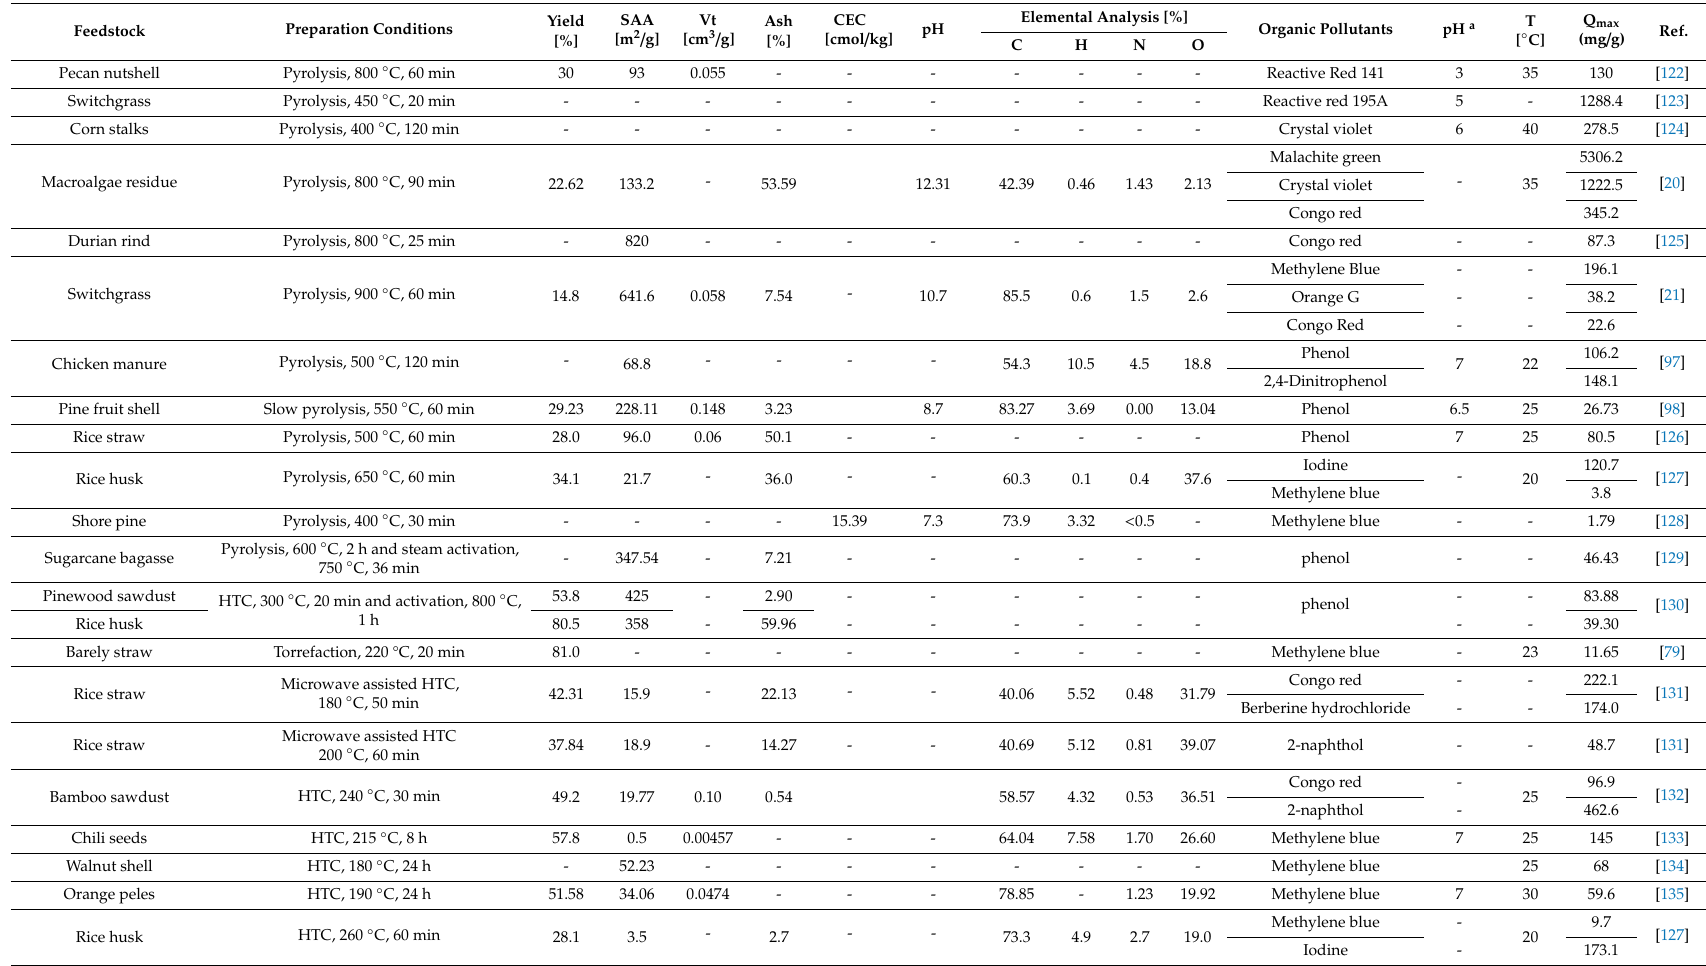
Table 2. Physico-chemical properties of various chars produced from di ff erent feedstock and by di ff erent thermal conversion methods for dyes and phenols removal. Feedstock